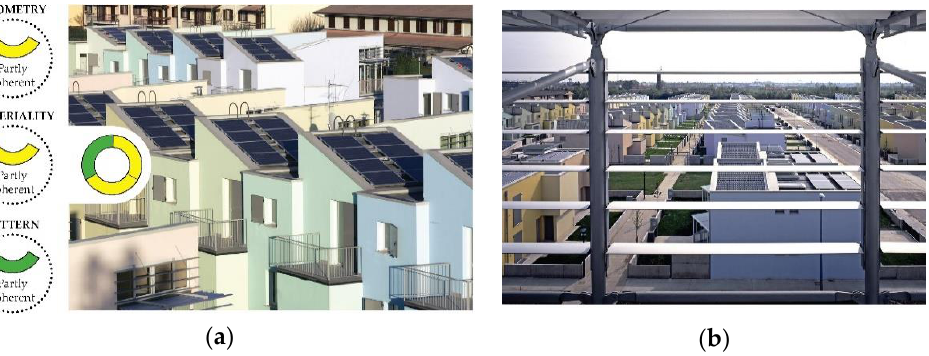
Figure 12. Architectural integration matrix for the PV systems at Violino District in Brescia (left); ( a ) system modular pattern (photo: © Fabio Cattabiani); ( b ) view from the roof of one of the multi- family houses (photo: © Fabio Cattabiani).